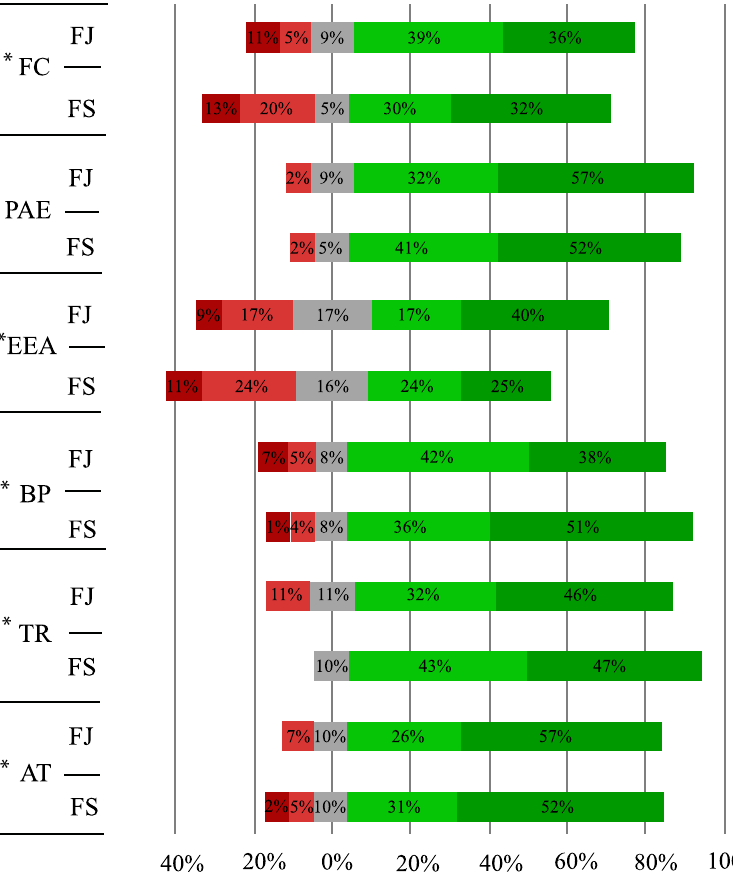
Figure 6. Distribution of acceptance and usability questionnaire answers. Feedback on screen (FS), feedback on joystick (FJ). Asterisks indicate that there are significant differences between